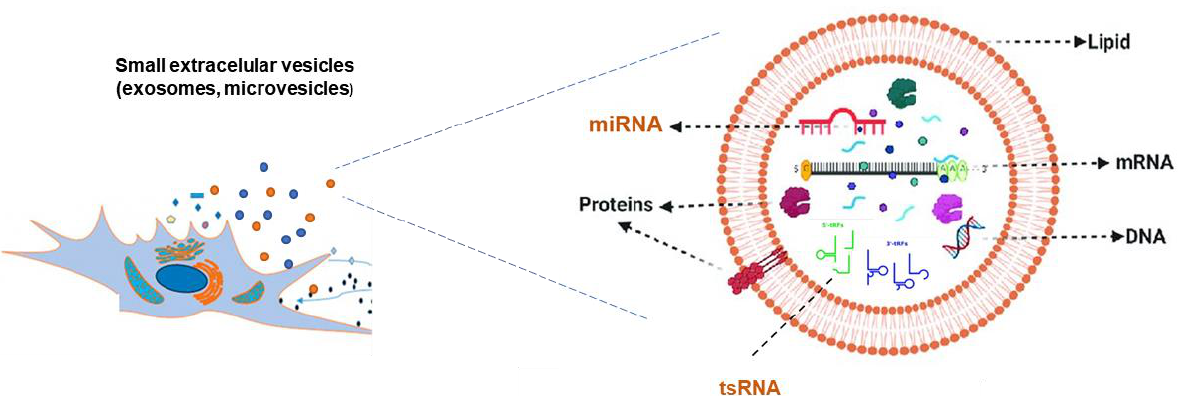
Figure 1. Both healthy and pathological cells release various types of membranous structures that are called small extracellular vesicles (sEVs; <200 nm of diameter) into the fluids. The sEVs are characterized by a high content of cholesterol and sphingomyelin. sEVs carry a very complex molecular load including proteins, DNA and RNA; RNA can be found in the form of mRNAs and non-coding regulatory RNAs, including small (depicted in orange) and long ncRNAs. All of this content can be transferred to other cells participating in paracrine signaling.